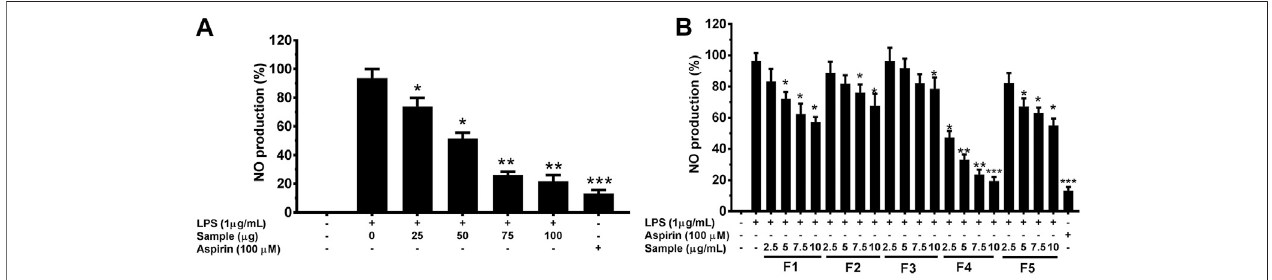
FIGURE 5 | Effects of crude extracts (A) and fractions (B) EtOH leaf extracts of G. uralensis on nitric oxide in RAW 264.7 cells. Cells (1.0 × 105 cells/ml) were stimulatedbyLPS(1 μ g/ml)for24 hinthepresenceofrudeextractsandfractionsatvaryingconcentrations.CulturemediawerecollectedinordertomeasureNObythe Griessreaction. Values are the mean ± standard error oftriplicate experiments. * p < 0.05, ** p < 0.01 and ** p < 0.001 for the comparison with theLPS-stimulated group.